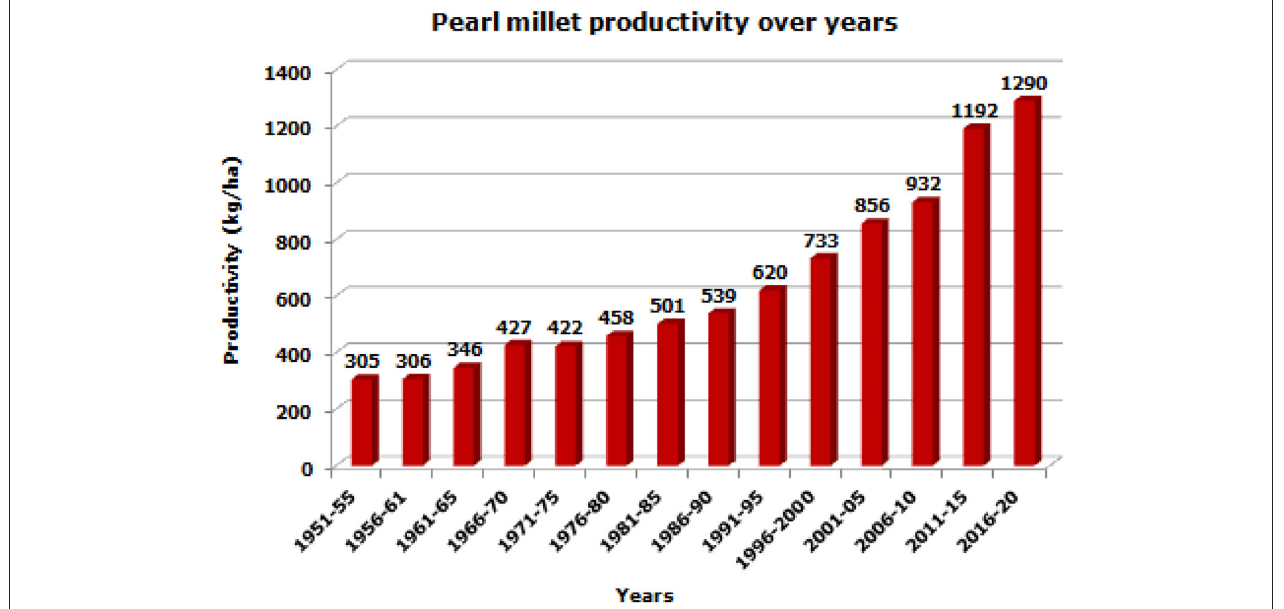
FIGURE 2 | Trends in pearl millet productivity over years (based on 5-year